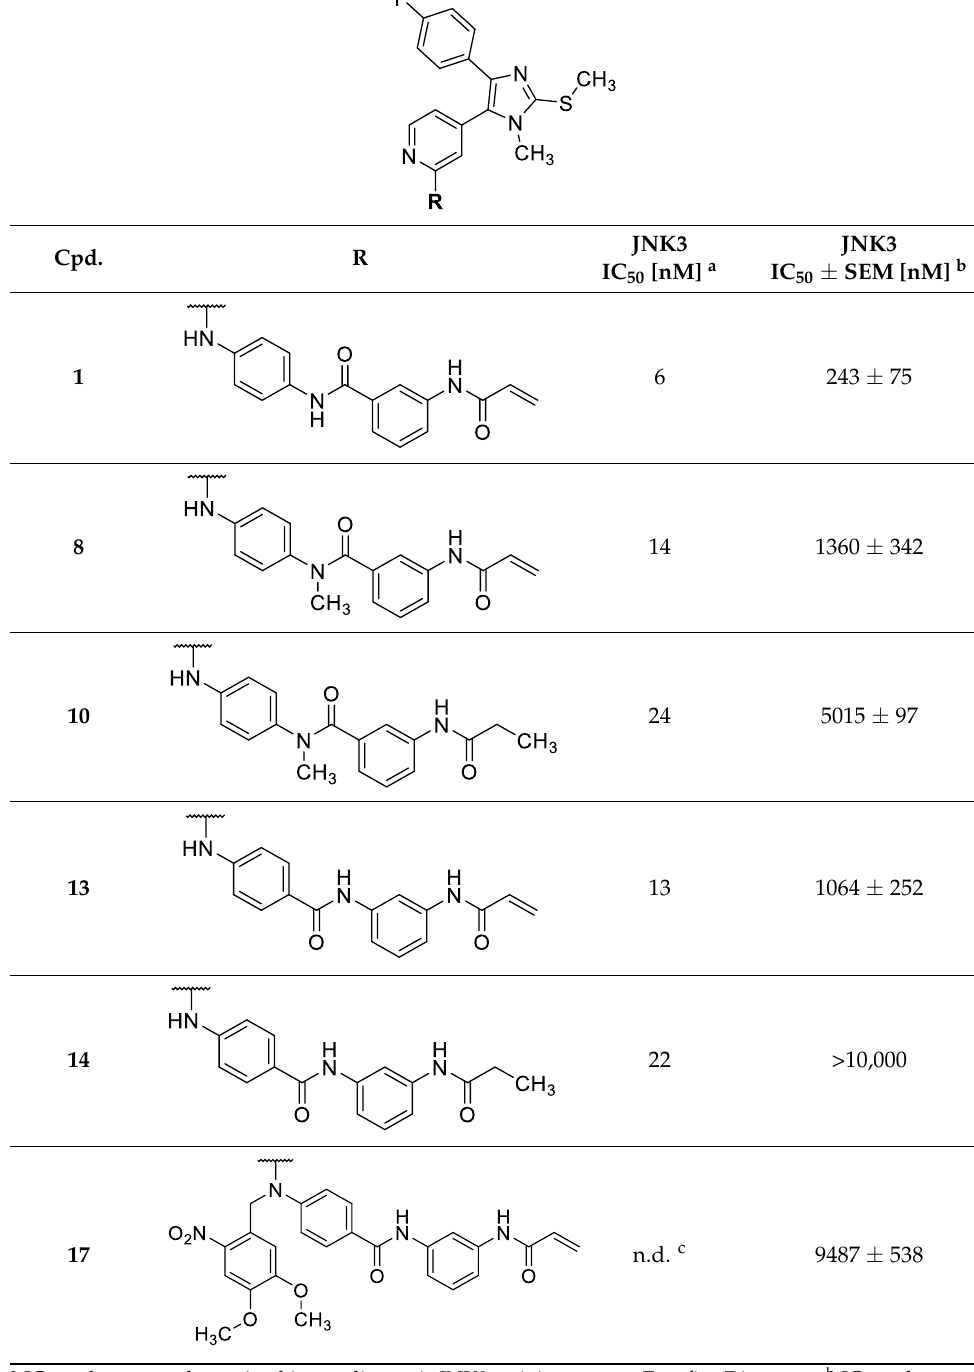
Table 1. Structures and biological activities of compounds 1 , 8 , 10 , 13 , 14 , and 17 . Cpd. Cpd. Cpd. Cpd. Cpd. Cpd.